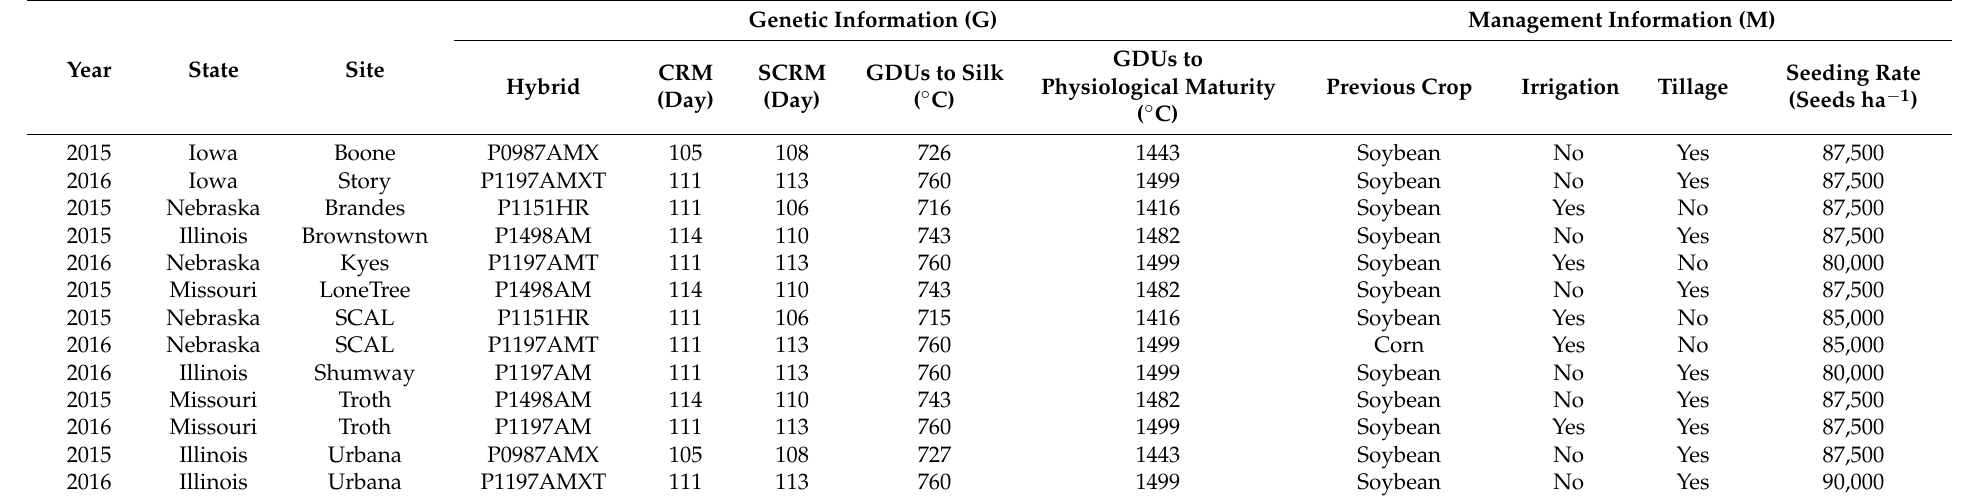
Table 4. Description of hybrid and management information for each site used in this